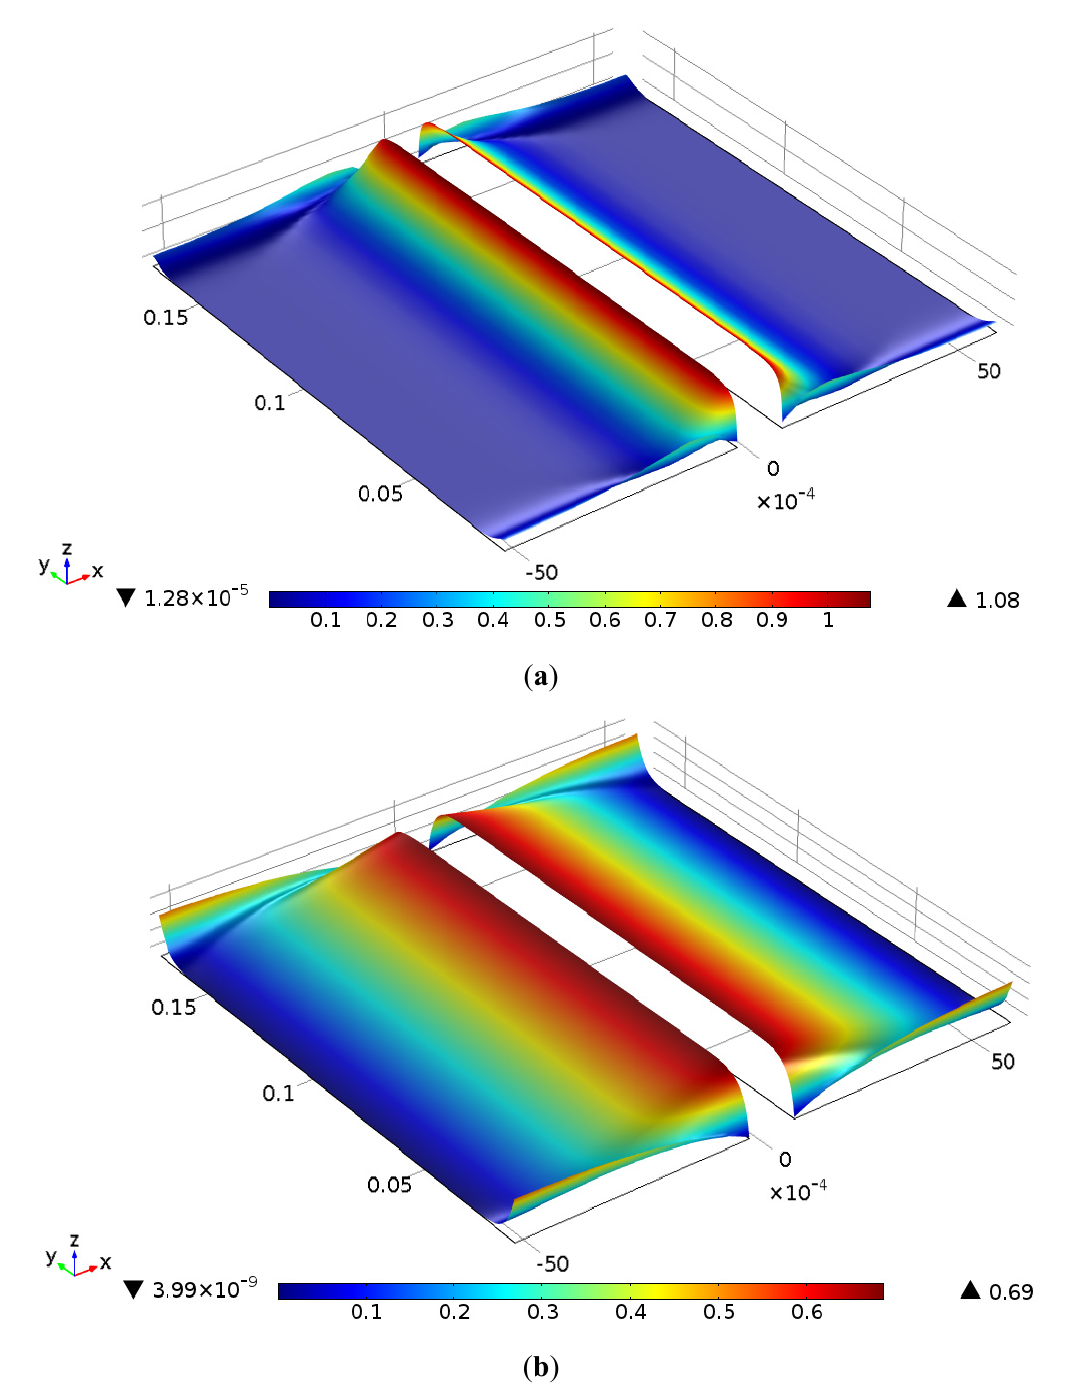
Figure 8. PV cell surface current density distribution under the short circuit condition for: ( a ) Profile 3; ( b ) uniform illumination distribution, x-axis is the bus-bar direction (m) and y-axis is the finger direction